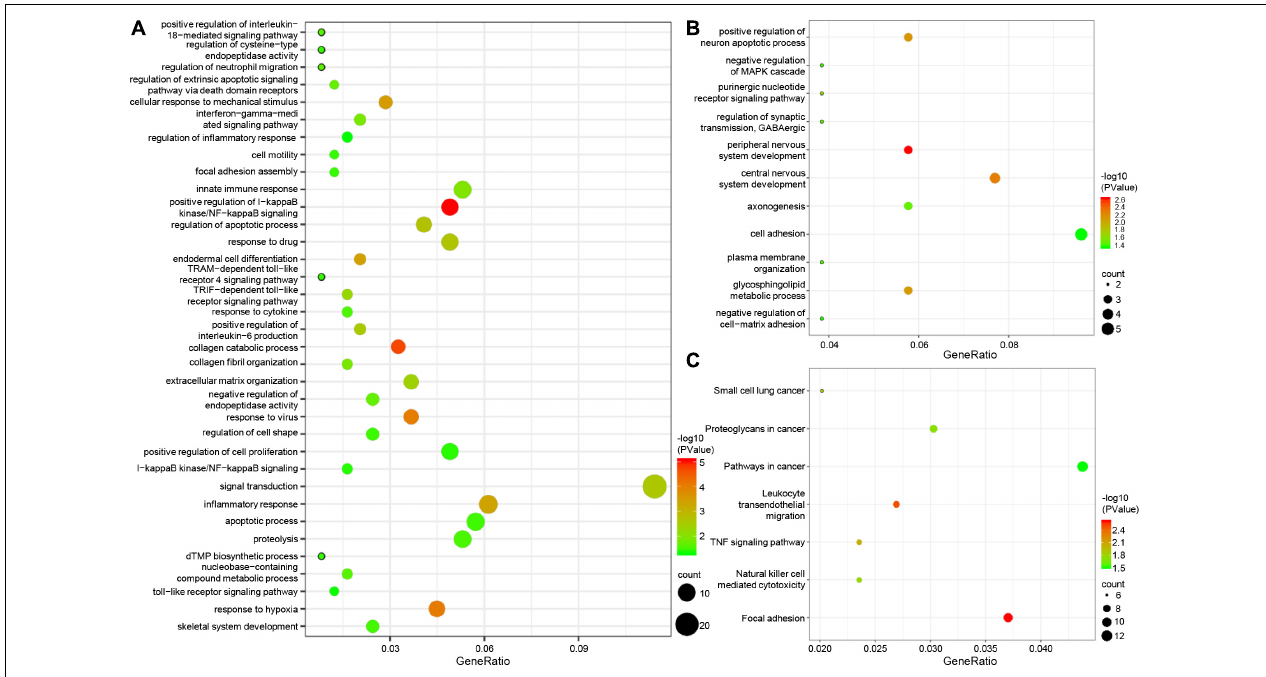
FIGURE 2 | GO and pathway enrichment analysis of epigenetic genes. (A) biological process of epigenetically induced genes. (B) Biological processes of epigenetically suppressed genes. (C) KEGG pathway analysis of epigenetic